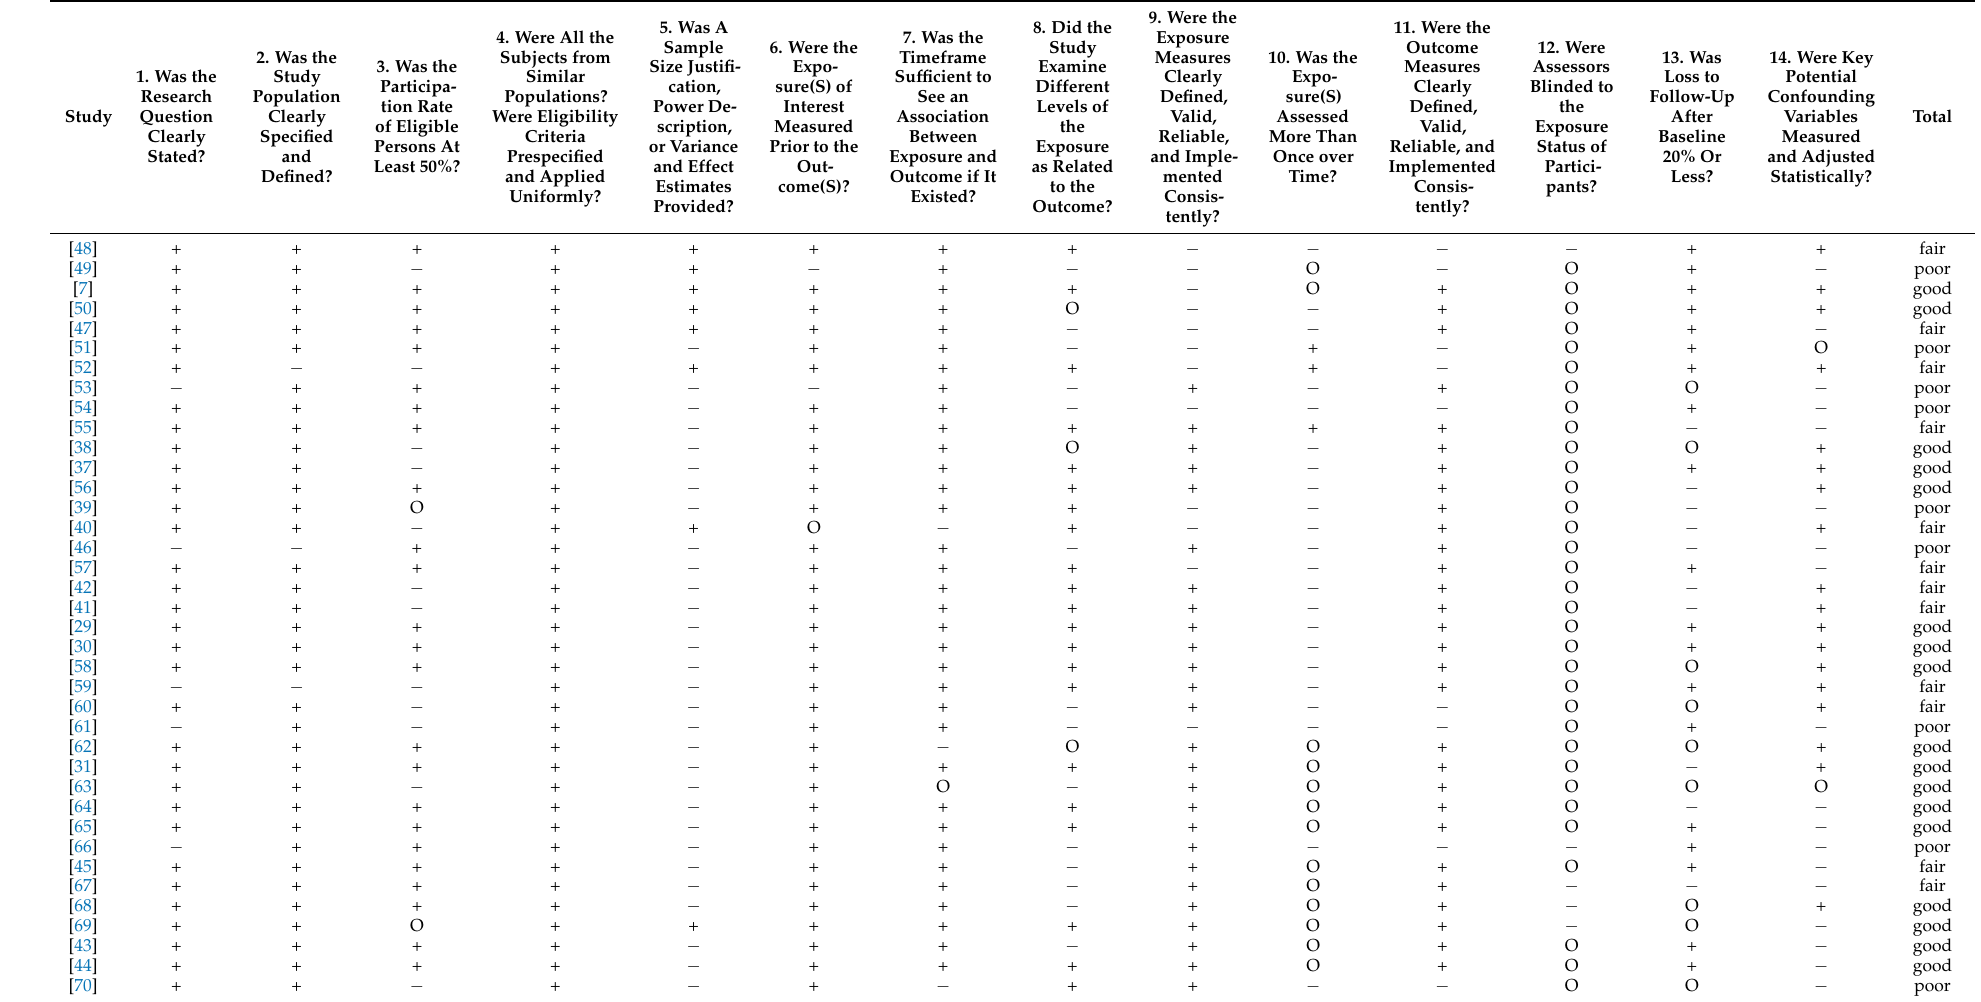
Table 2. Quality assessment with the National Heart, Lung, and Blood Institute Study Quality Assessment Tools For observational cohort and cross-sectional